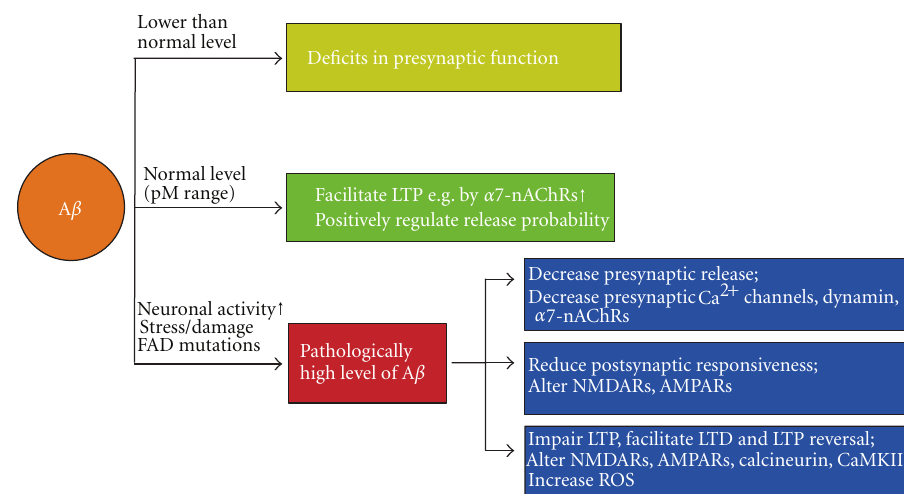
Figure 2: Concentration-dependent e ff ects of A β on synaptic function. At normal physiological levels (picomolar range), A β peptides have positive e ff ects on synaptic function: they can positively regulate presynaptic release probability and facilitate learning and LTP in CA1 by activating α 7-nAChRs. However, when the concentration of A β peptides is lower than normal, presynaptic function is impaired. On the other hand, under pathological conditions, such as increased neuronal activity, stress, or the presence of familial Alzheimer’s disease (FAD) mutations, the increase in A β peptide concentration produces pathological e ff ects, including decreased presynaptic neurotransmitter release, reduced postsynaptic responsiveness, LTP impairment, and LTD facilitation. Therefore, maintaining the concentration of A β peptides within a normal physiological range is essential and should be the goal for developing e ff ective treatments for Alzheimer’s